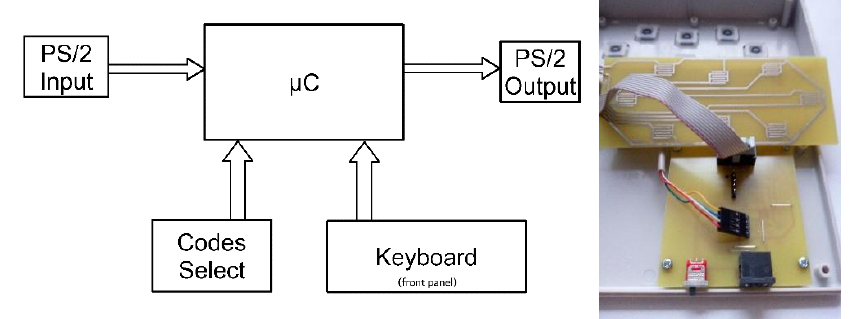
Figure 2. A block diagram and the structure of the new device.